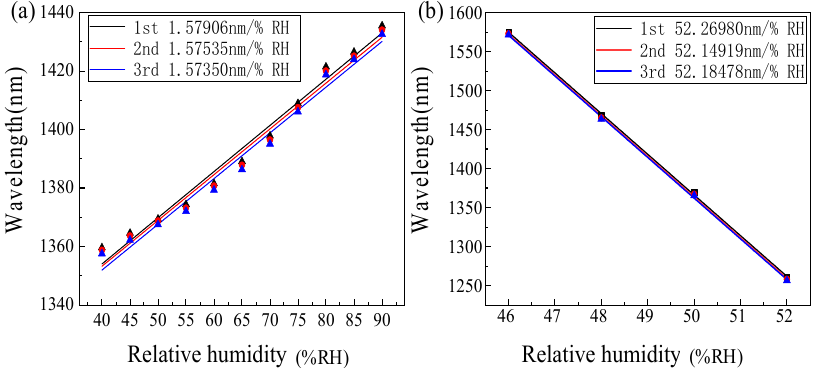
Figure 12. Repeated experiment results. ( a ) Upper envelope response in repeated experiment and ( b ) the inner envelope response was fitted in the repeated experiment.